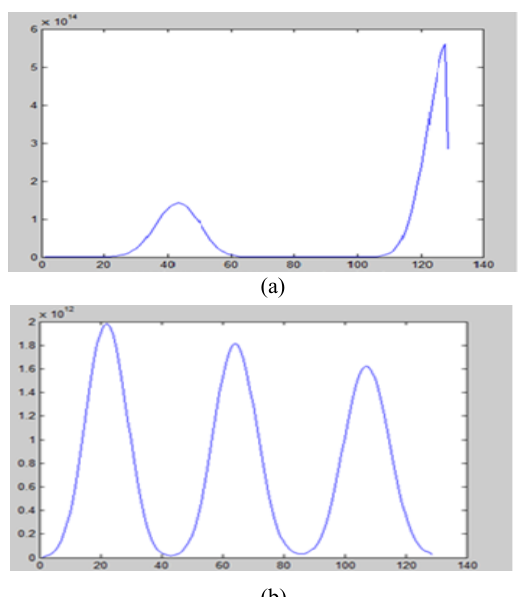
Figure 4: (a) Periodogram of output SHG wave using Welch in THz radiation, (b) Periodogram of output THG wave using centrosymmetric material